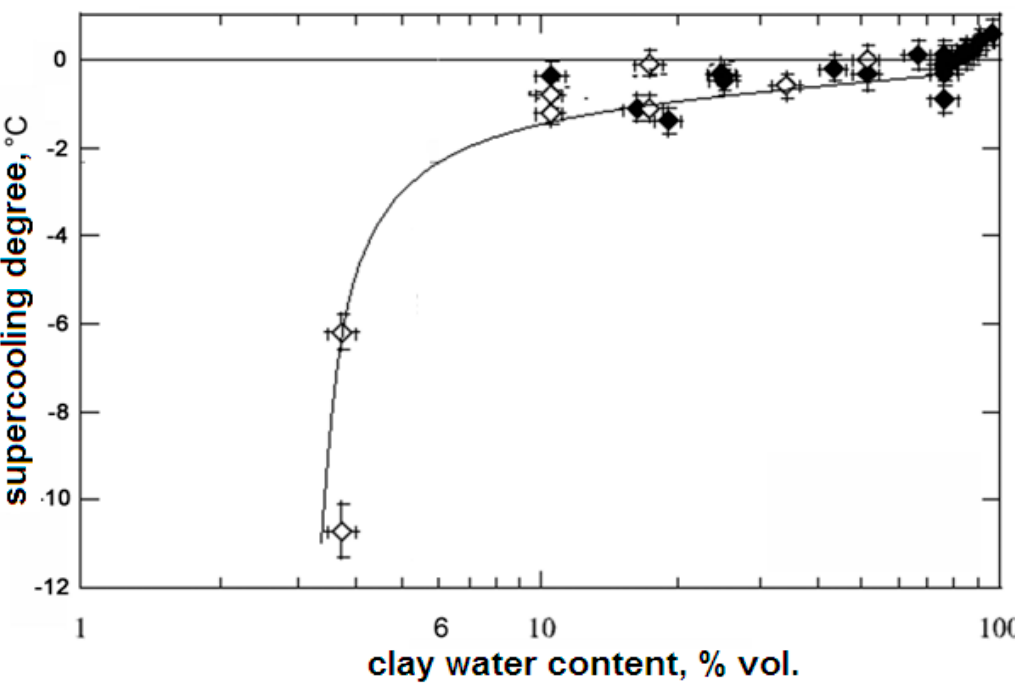
Figure 2. Shift of hydrate formation temperature in the bentonite with different water contents, comparing the equilibrium temperature in the system “methane—deionized water” (curve—approximation of data from [7].